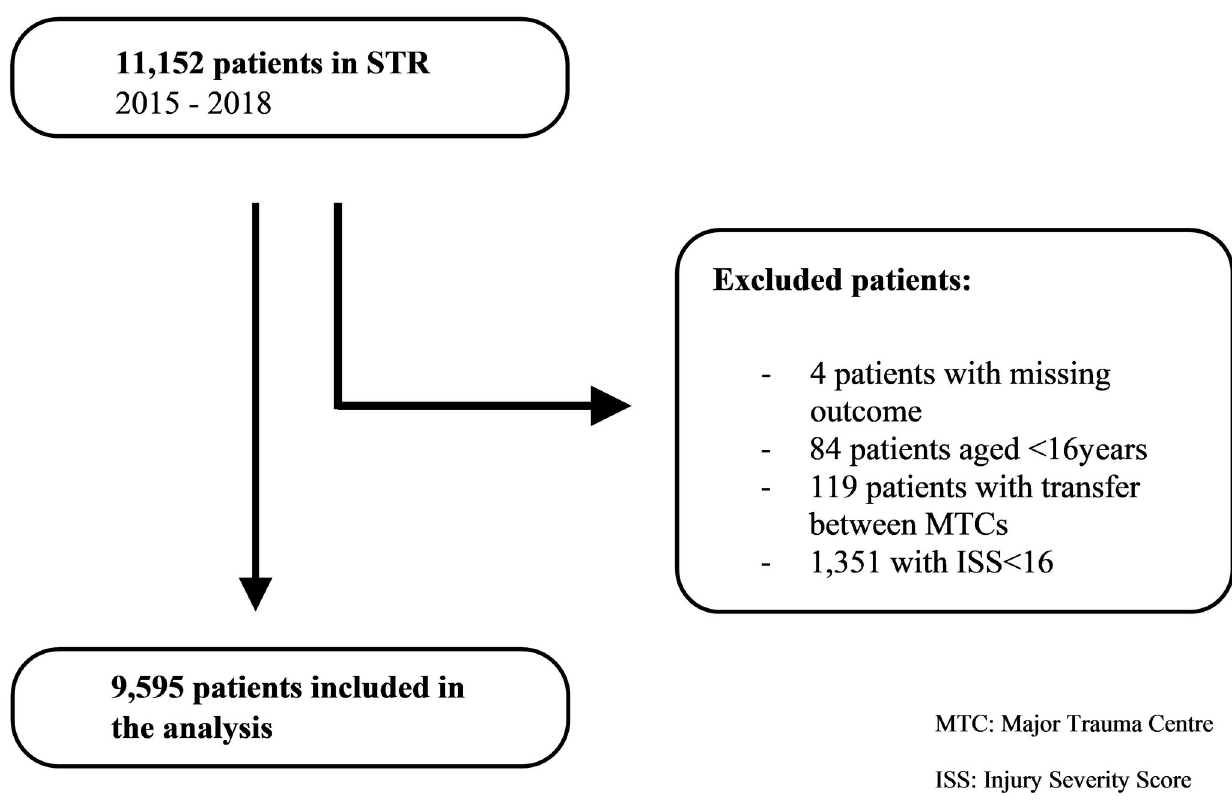
Fig 1. Patients‘flow chart. 5,441 patients (57%) suffered from severe TBI, and 2,800 (51%) from isolated severe TBI (Table 1). Overall, 14% (n = 779) of patients with severe TBI died. For patients who died, the median ISS was higher (median 26 vs. 20) and the GCS lower than for those who survived.